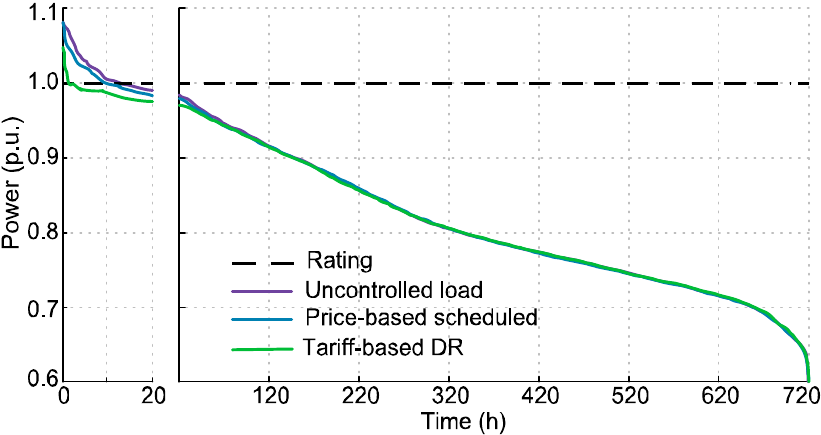
Figure 9. Monthly load duration curve.